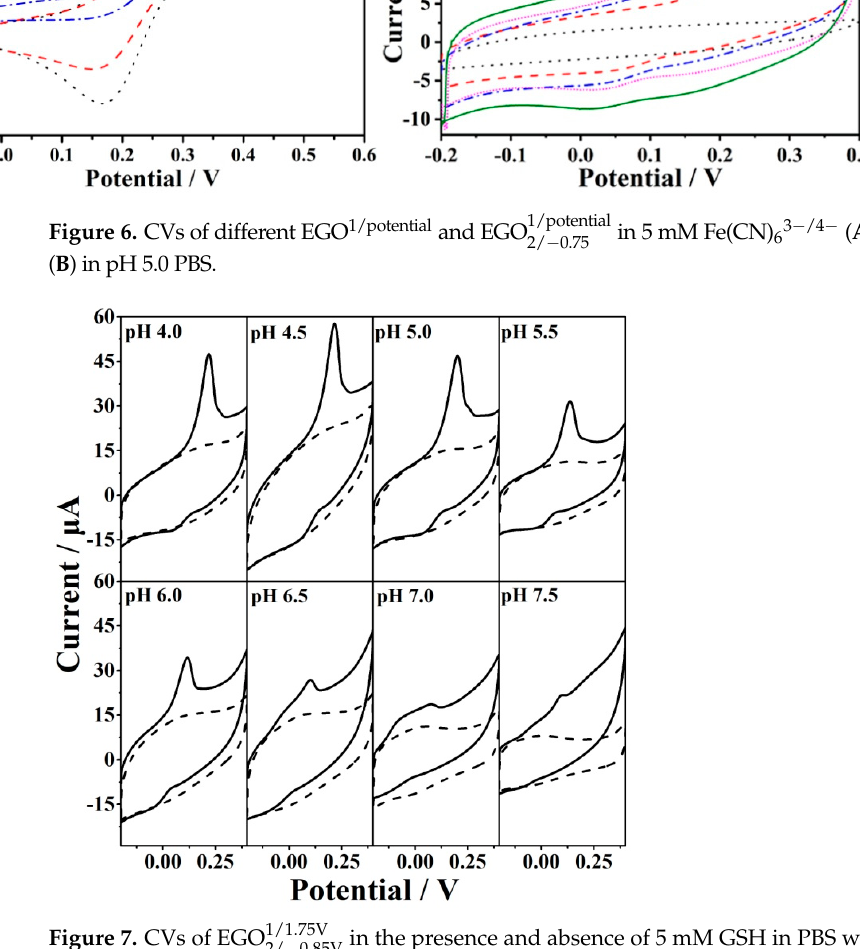
of 0.2 V (Figure 8). The response current increased with the addition of GSH, and a linear response was observed over a concentration range from 1 μ M to 1.09 mM with a calcu ‐ lated LOD of 0.3 μ M. When the concentration was higher than 1.09 mM, the response was unstable and deviated from linearity. This is caused by chemical fouling of the elec ‐ trode surface derived from the oxidation product GSSG. The current responses of the electrode to various concentrations of GSH in a static 0.1 M PBS (pH = 4.5) were also performed (Figure S6). The current increased linearly with the concentrations of GSH in a wide range from 1 μ M to 2 mM. Figure 8. Amperometric response of EGO (cid:2870) / (cid:2879)(cid:2868) . (cid:2876)(cid:2873)(cid:2906)(cid:2869) / (cid:2869) . (cid:2875)(cid:2873)(cid:2906) to the successive injection of GSH in a stirred 0.1 M PBS (pH 4.5) at an applied potential of 0.2 V. Inset ( A ) is the calibration curve for the